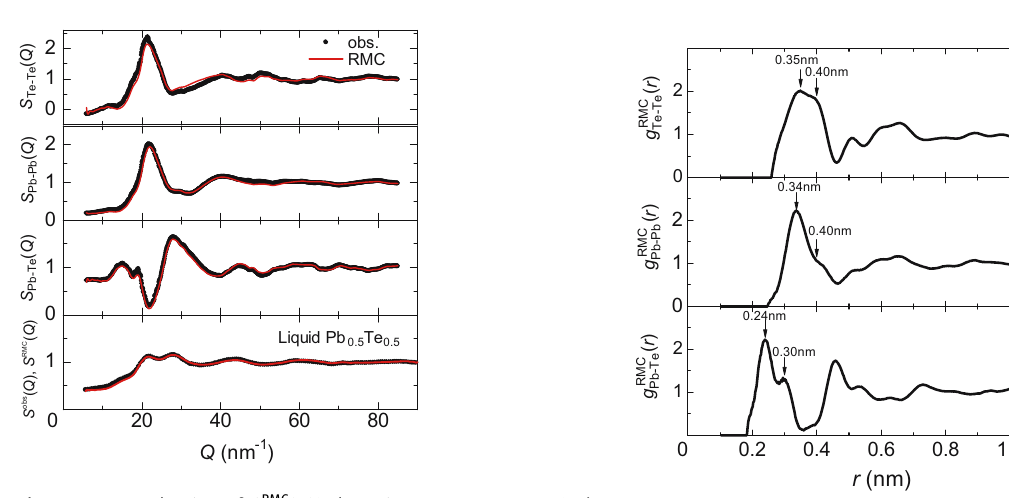
of Figure 6: Partial pair distribution function ( ) g r three dimensional configuration of Pb 0.5 Te 0.5 by using RMC